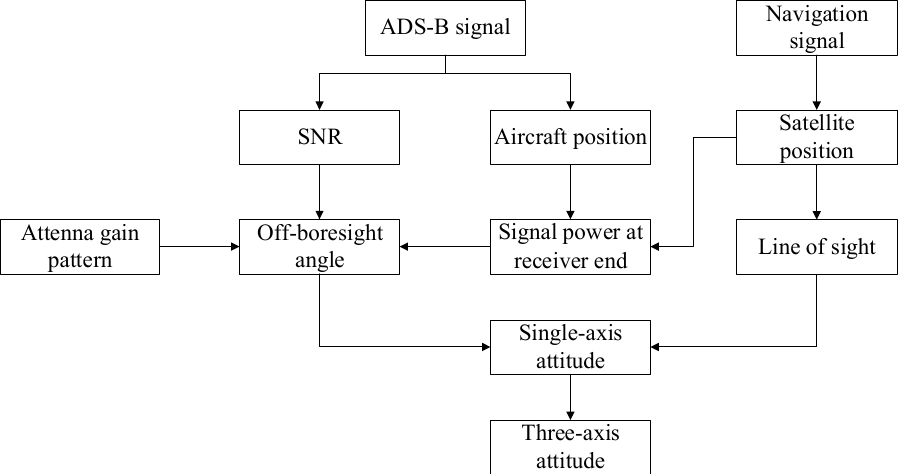
Figure 2. Basic principle of ADS-B-based three-axis satellite attitude determination.